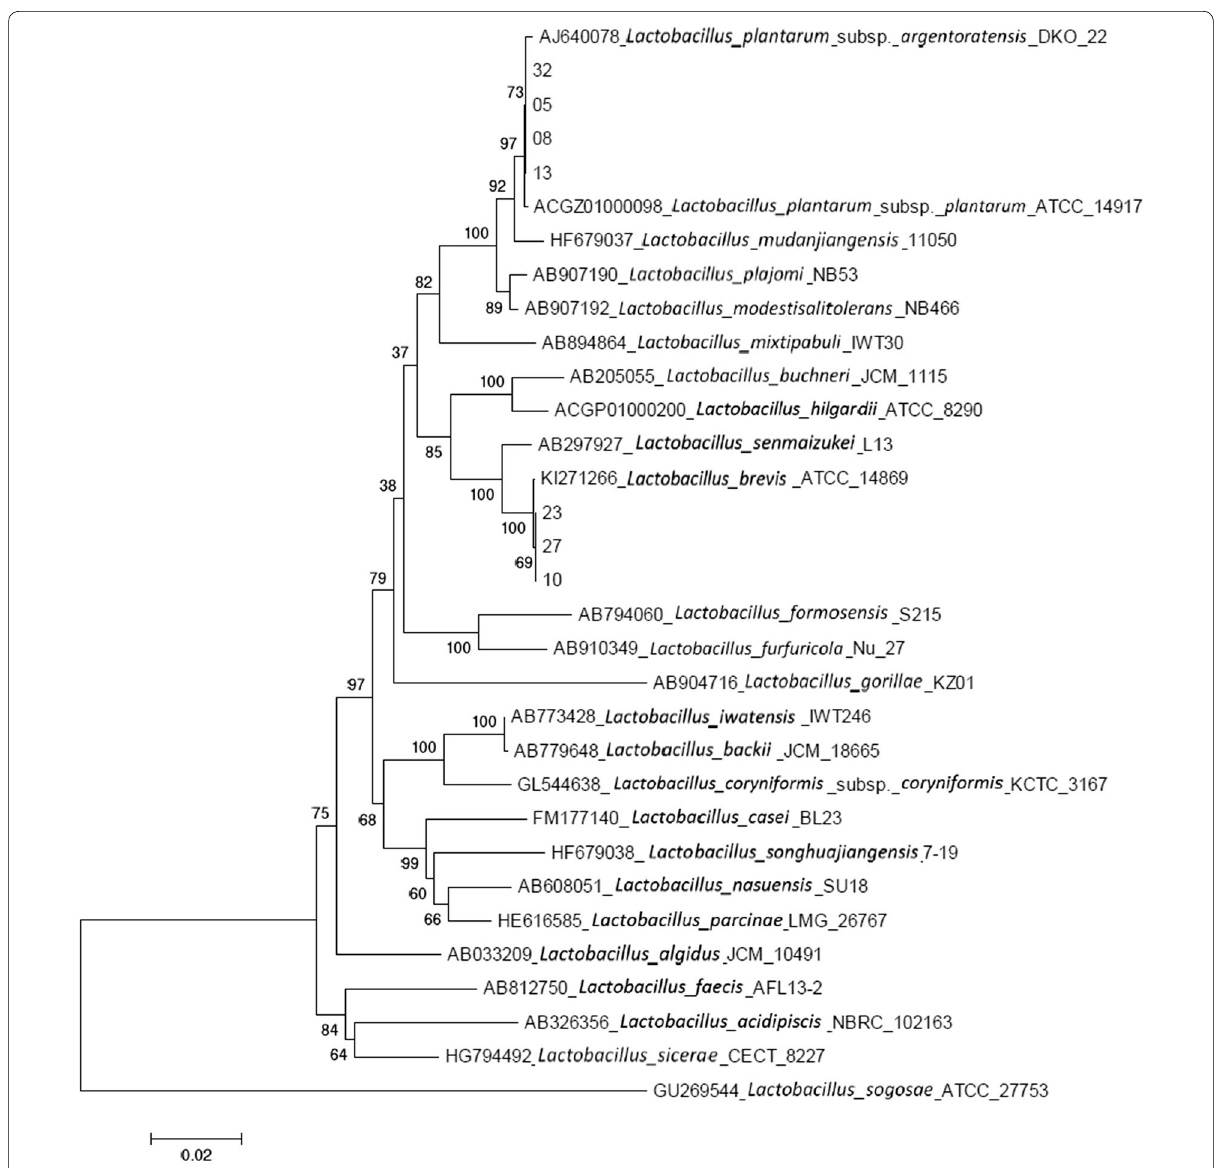
Fig. 3 Phylogenetic tree based on 16 S-rDNA sequences of 7 strains